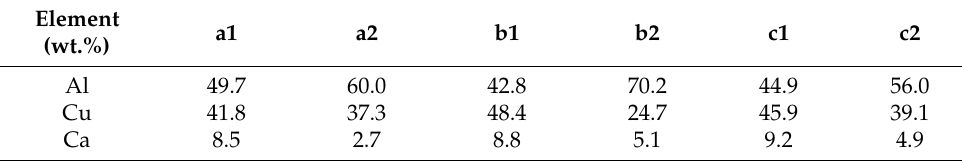
Table 1. Chemical compositions of Al-Cu-Ca alloys in Figure